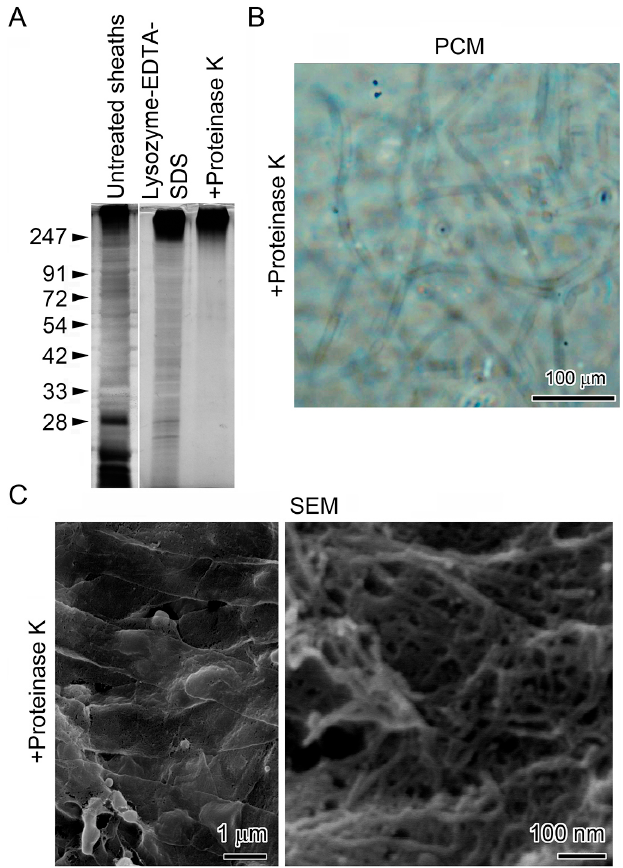
Figure 6. Structural alteration of tubular structures and fine fibrils of LES-treated sheaths after ProK treatment. ( A ) Silver-stained SDS-PAGE gel loaded with the untreated cell-encasing sheath fraction ( left lane ) and with those treated with LES ( middle lane ) or LES/ProtK ( right lane ). Note the high molecular weight material (>250 kDa, probably corresponding to glycoprotein) that did not migrate at the top of each lane; ( B ) PCM image of sheath remnants after ProK treatment; ( C ) SEM images of LES/ProK-treated sheaths. Note nano-scaled fibrils released from sheaths ( right ).